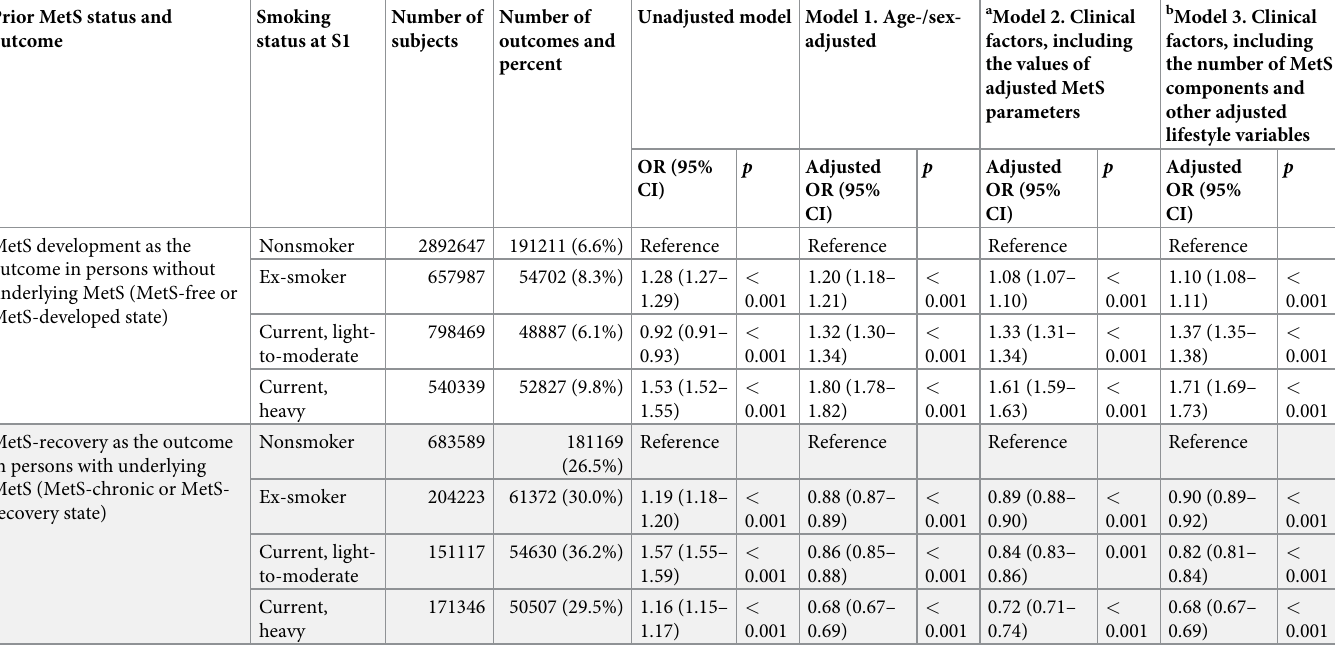
Table 2. Smoking status and its association with recovery from or development of metabolic